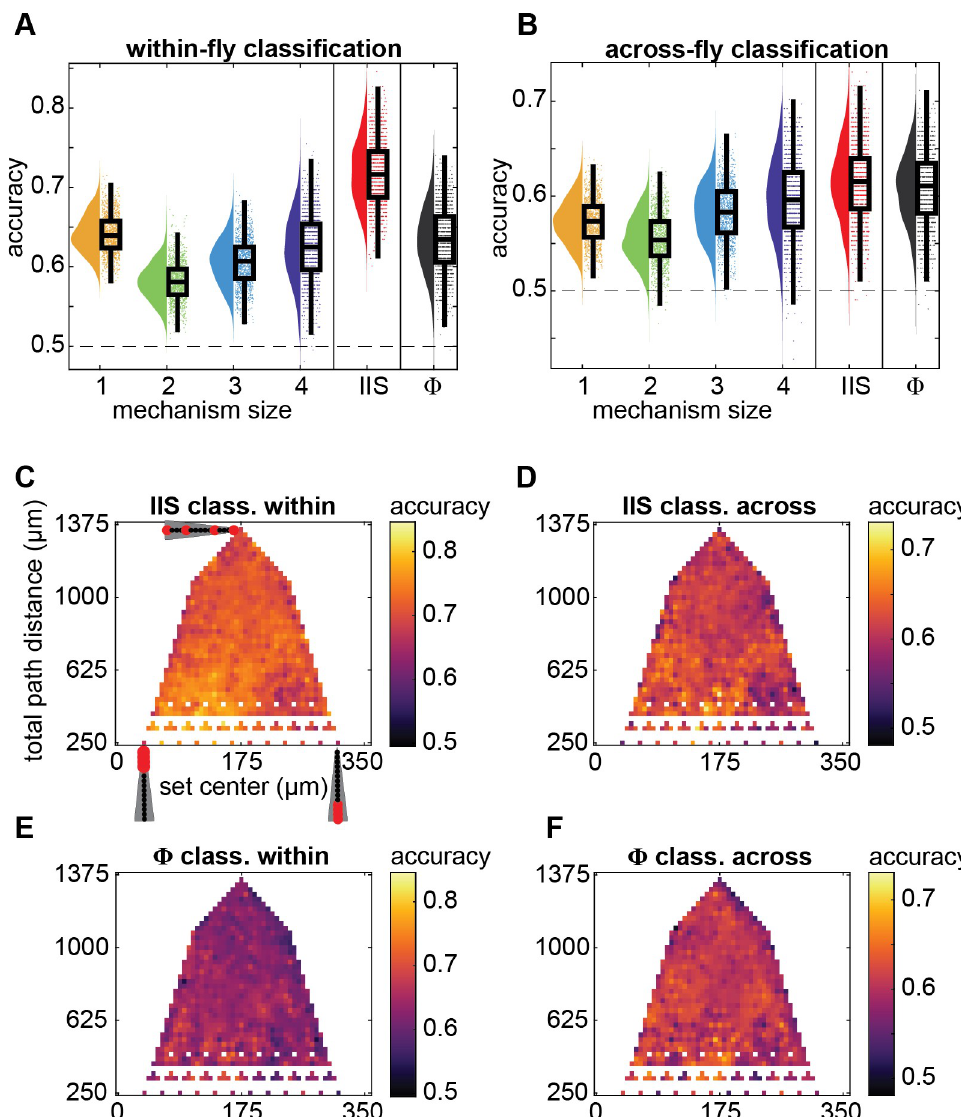
Fig 5. Classification of wakeful vs. anesthetized conditions using mechanism-level φ , system-level F , or the integrated information structure (IIS: a set of φ ’s). ( A ) Within-fly and ( B ) across-fly classification at each individual channel set using individual φ values for each mechanism size (orange, green, pale and dark blue are 1-, 2-, 3-, and 4-channel mechanisms, respectively; single-feature classification), when using the IIS (i.e. all mechanisms together, 15-feature classification, red), and when using F (single-feature classification, black). Individual points are classification accuracy of each channel set, after averaging accuracies across all mechanisms within the same mechanism size. Boxplots show median, 25th-75th percentiles, and whiskers are 1.5 interquartile below and above respectively. ( C - F ) Spatial map of classification accuracy (same format as in Fig 3). Within-fly ( C ) and across-fly ( D ) classification accuracies when using the IIS. Within-fly ( E ) and across-fly ( F ) classification accuracies when using F . information only outperformed 2-channel integrated information ( β = 0.018, t (7) = 3.161, p = .016), with (3) 4-channel integrated information achieving greater accuracies than 1-, 2-, and 3-channel integrated information ( β = 0.023, t (12) = 2.515, p = 0.040, β = 0.042, t (7) = 7.976, p < .001, and β = 0.014, t (7) = 6.250, p < .001, respectively). As for within-fly classification, sys- tem-level integrated information attained similar performance to the highest performing